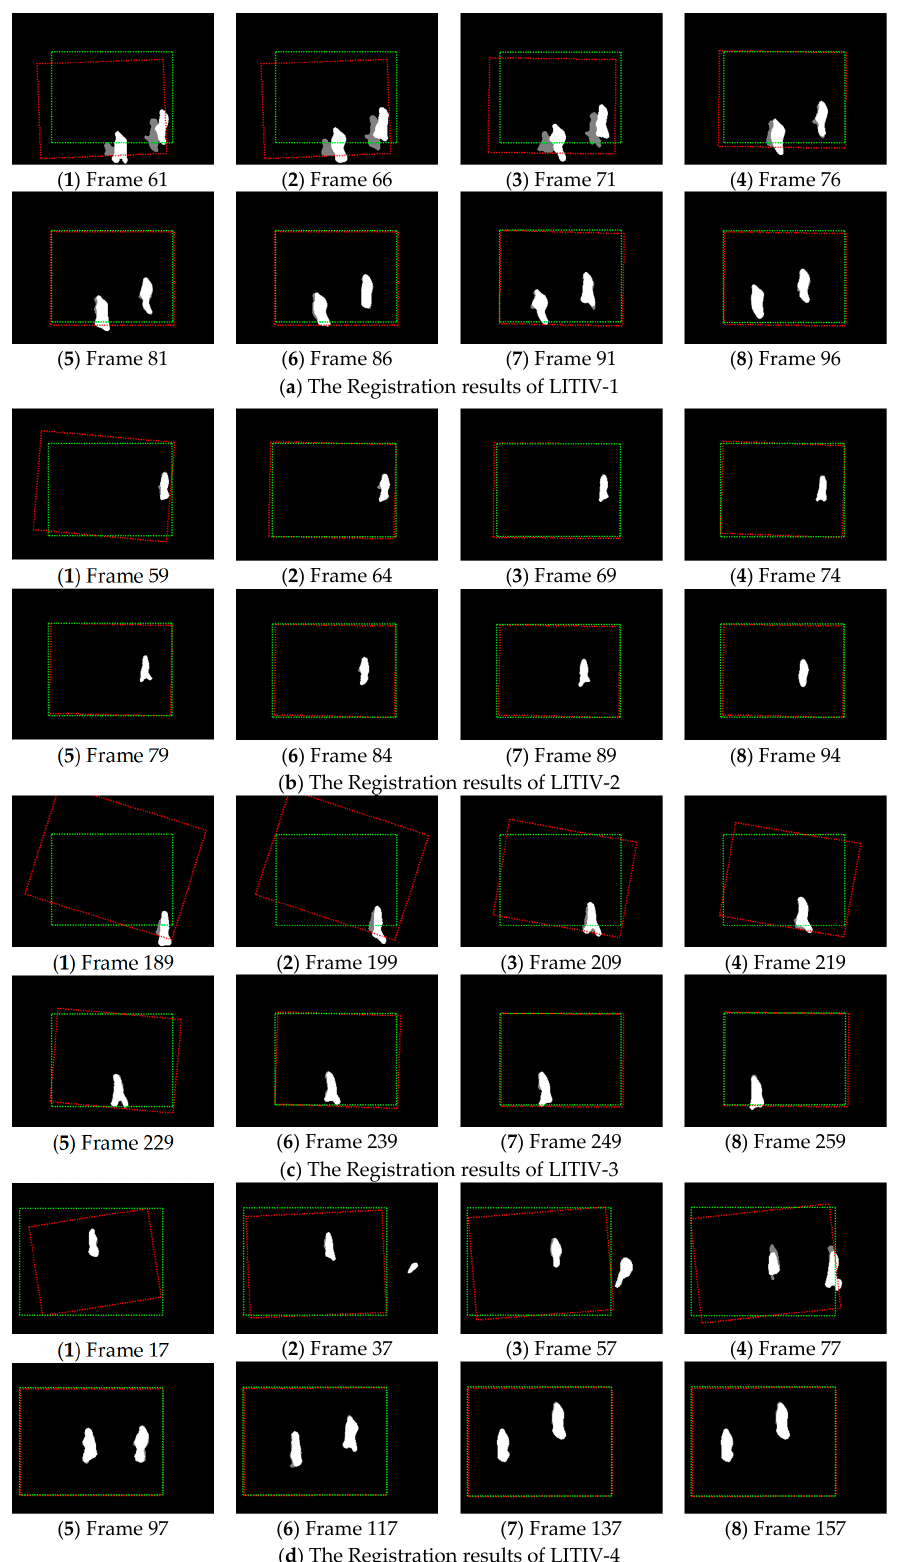
Figure 7. ( a – d ) Registration results obtained at various moments of the first, second, third and fourth video pairs of the LITIV dataset using our proposed framework. The red-dashed rectangle shows the estimated transformation applied to the infrared image boundary, and the green one shows the ground-truth transformation applied to the same boundary.